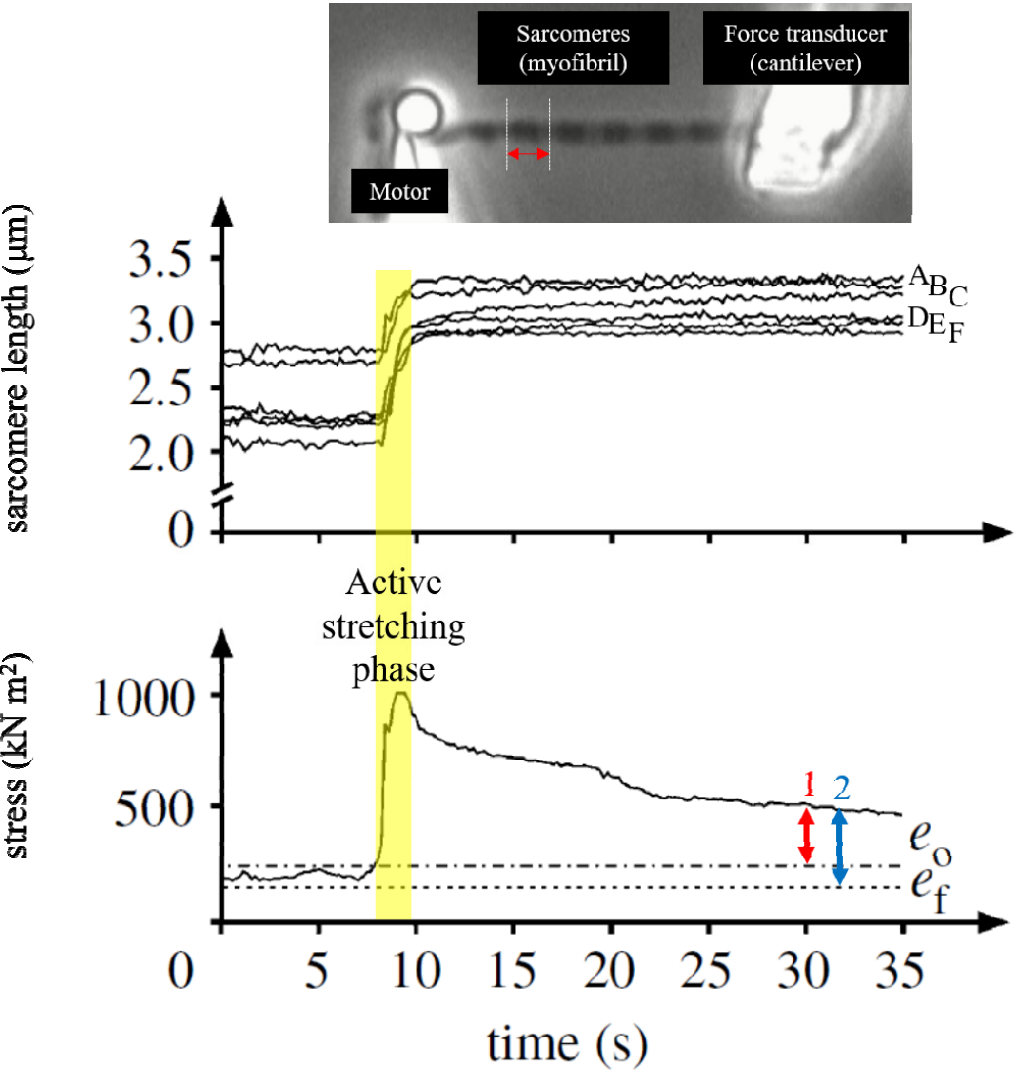
Figure 5. Sarcomere lengths changes before and after active stretching in a single myofibril preparation [12]. This myofibril had six sarcomeres and each sarcomere length was monitored throughout the trial. Thus, there are six traces in the upper graph. The steady-state isometric force after stretch was larger than the purely isometric force obtained at the same sarcomere length ( e f , 2 and the force measured at the optimal sarcomere length ( e 0 , 1) (lower panel). The increased isometric force, indicated by the blue arrow, represents the magnitude of rFE. If rFE was caused by the development of sarcomere length non-uniformities, this enhanced isometric force should not exceed the isometric force attained at the optimal length. However, the isometric force in the enhanced state was greater than the isometric force at optimal sarcomere length, as indicated by the red arrow). In the enhanced force state, sarcomere length was indeed di ff erent among sarcomeres, but this di ff erence seems to be stable, and similar sarcomere length di ff erences were also observed in the purely isometric contraction (non-enhanced state). (Reprinted with permission).